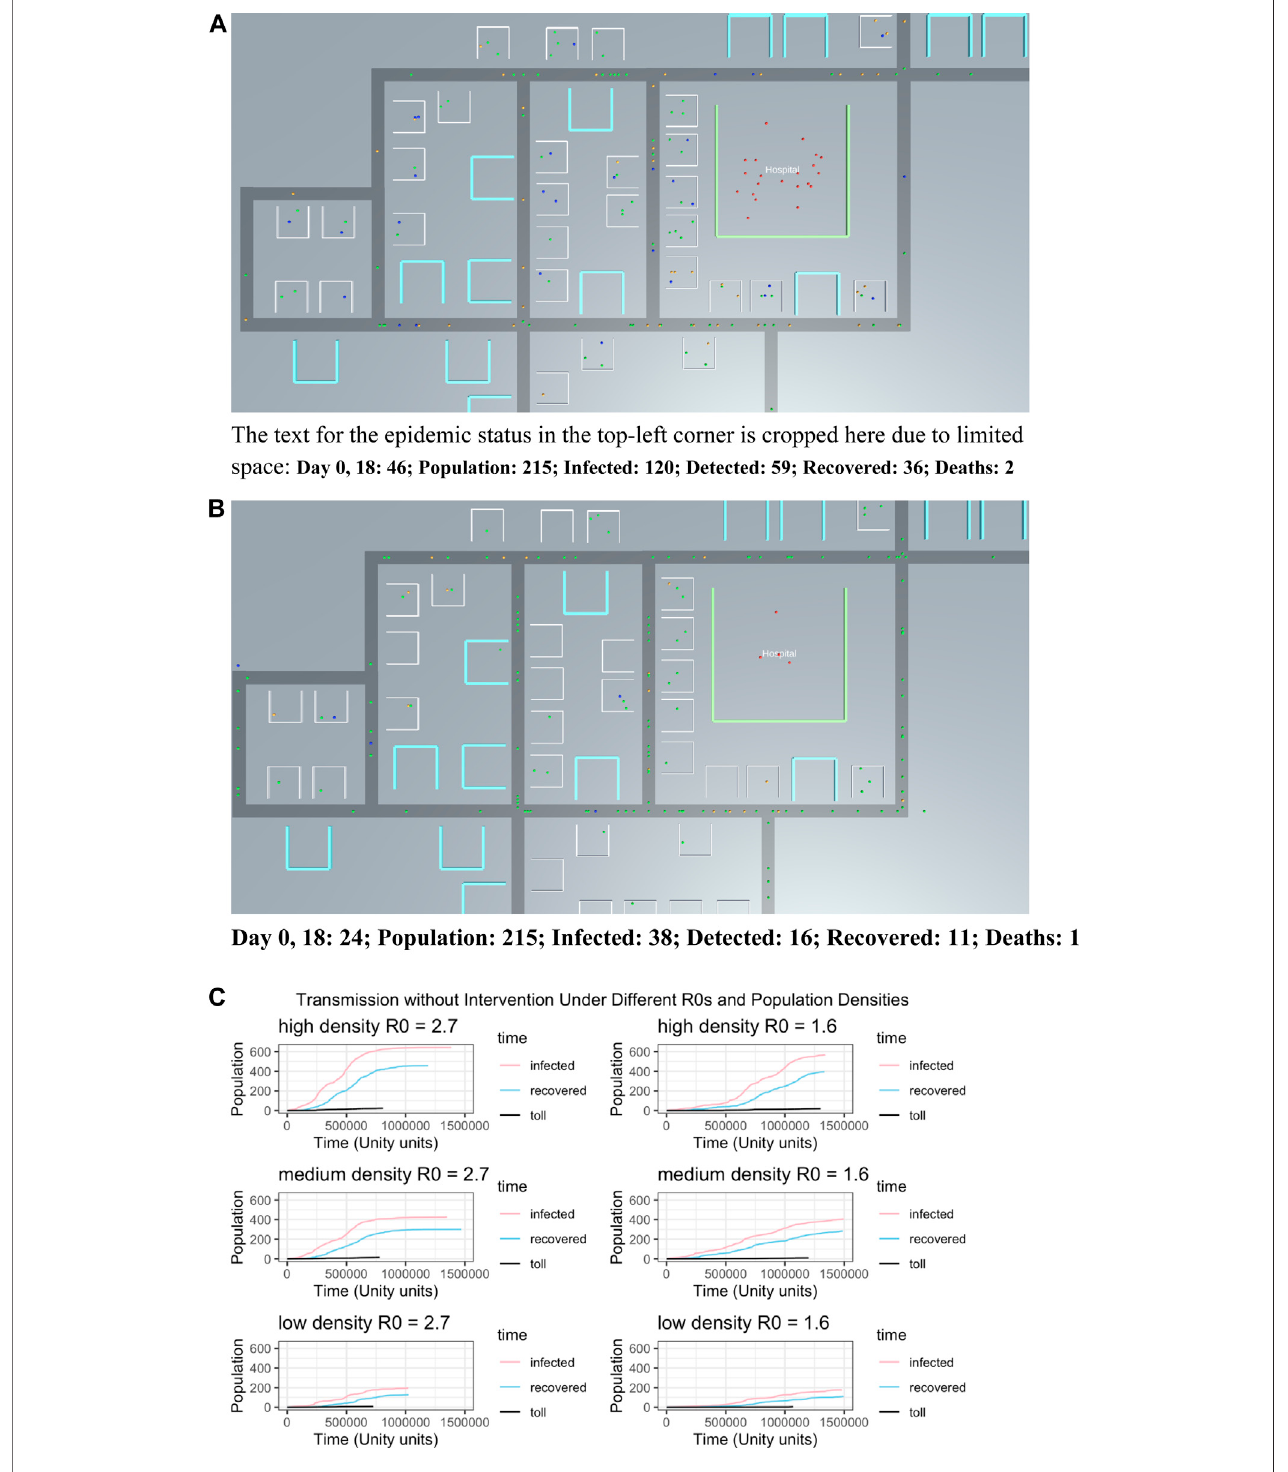
FIGURE1| Theresultsofdifferentsimulationsgivendifferentparametersettings: (A) screenshotofthesimulationgivenR0 (cid:1) 2.7 (B) sameasinsubplota,butwith R0 (cid:1) 1.6 (C) shows howpopulationdensity changestherate ofinfection over time forthetwodifferentR0valuesshown insubplotsaand b.Lines ineach subplotshow time course of infected, recovered and death toll count for each set of conditions.